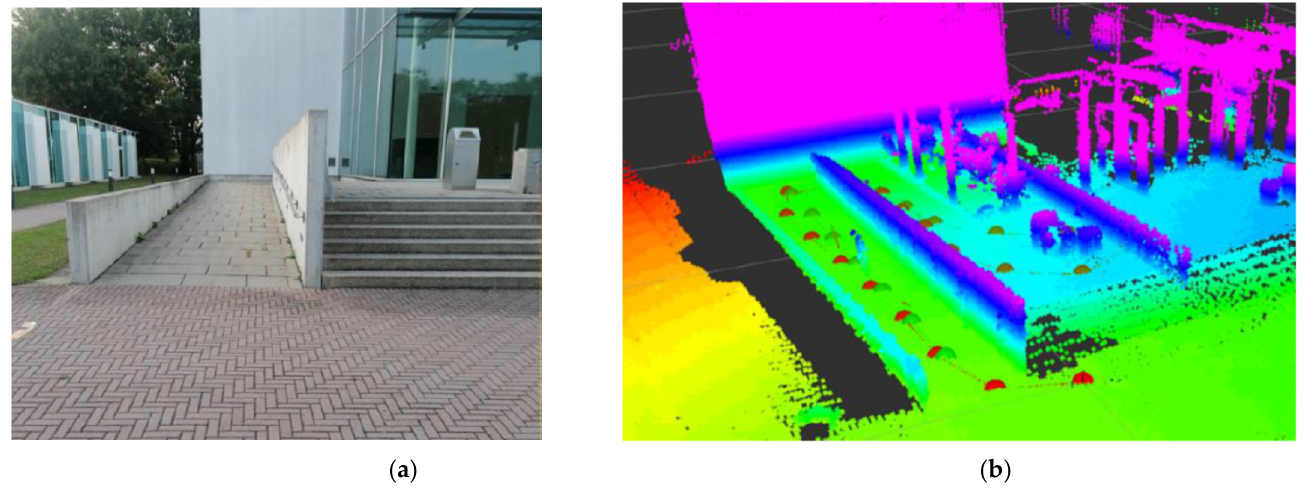
Figure 19. ( a ) Test track. ( b ) Map created using hdl_graph_slam from the wheelchair ramp of the D- building.